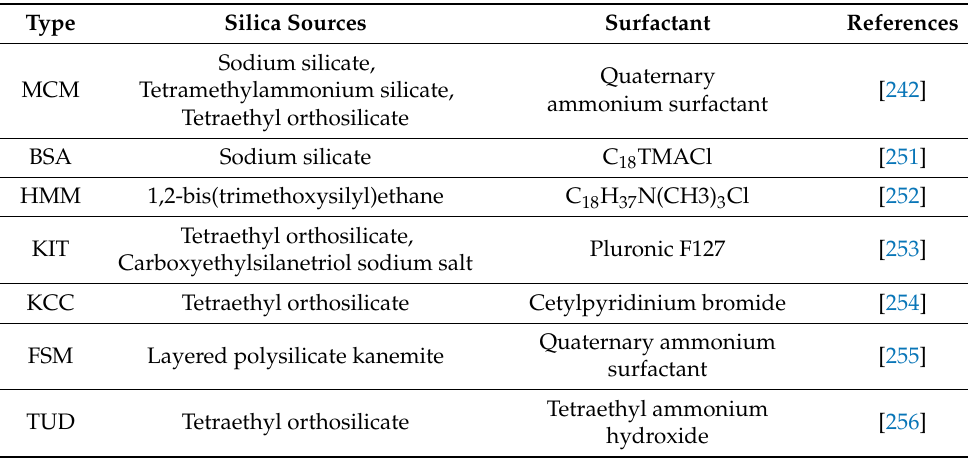
Table 8. Synthesis of different series of